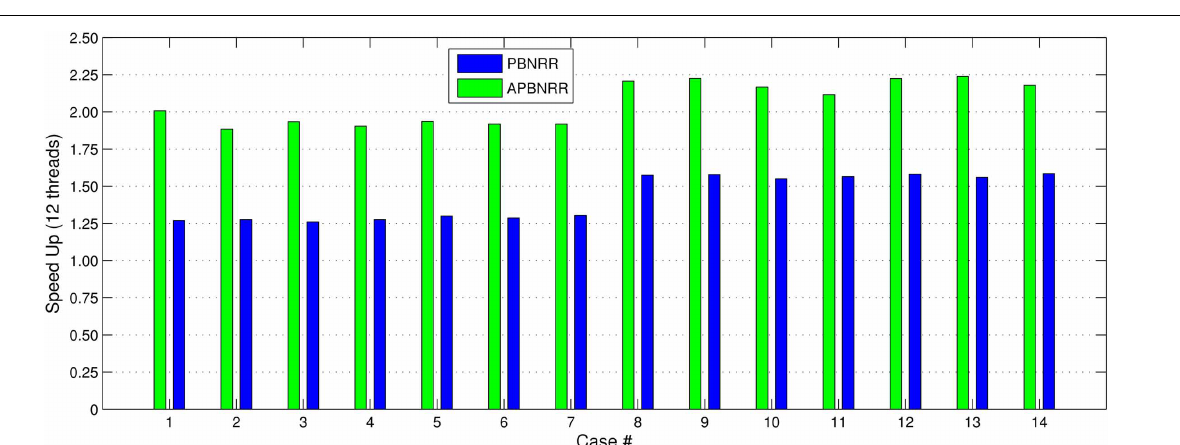
Seg. Correction, Image Def. Field Correction and FEM